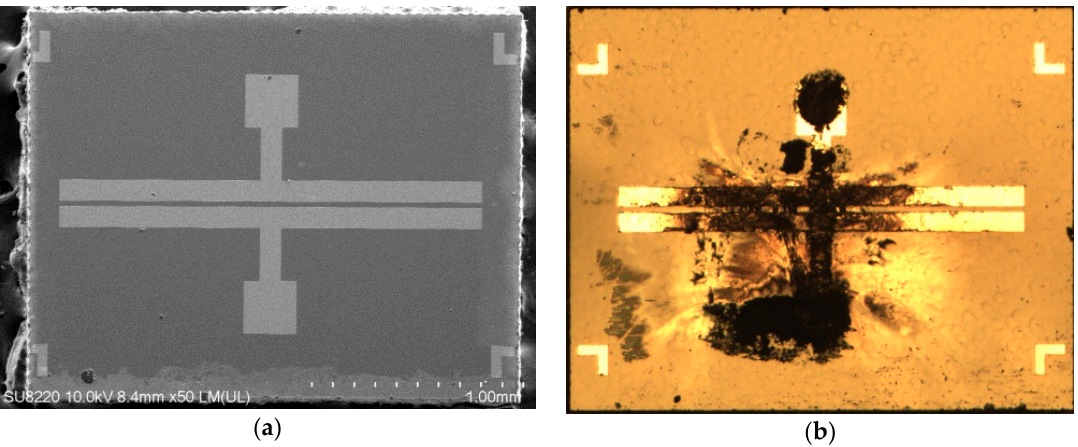
Figure 5. Images of the ( a ) normal MSM varactor and ( b ) breakdown state after the injection of a 600-A malicious current pulse.